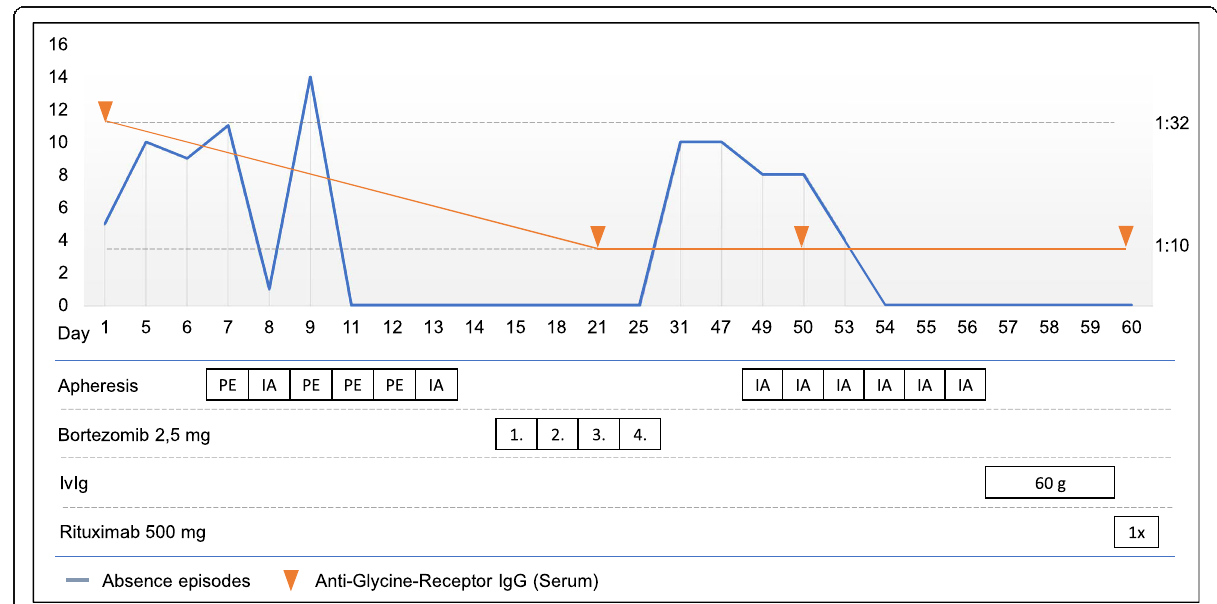
Fig. 1 Frequency of absence episodes and titers of anti-glycine receptor-Abs in relation to the course of therapy. Please note that the timeline on the x-axis is